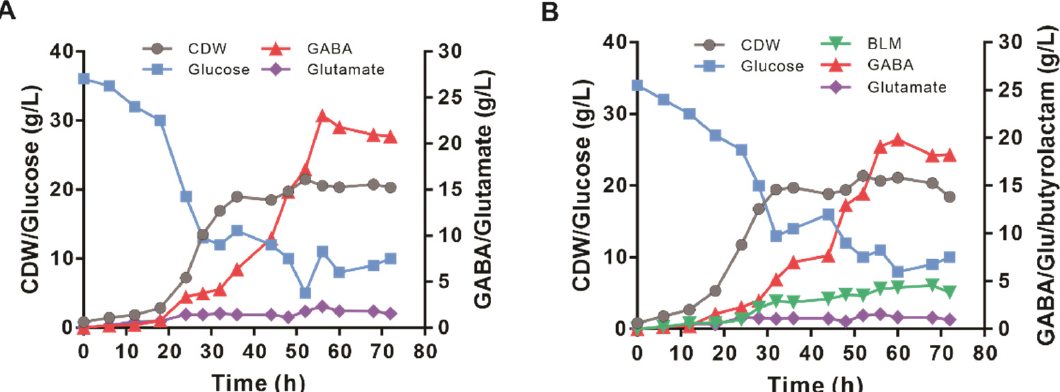
Figure 6. Fed-batch fermentation profiles of the engineered GABA and butyrolactam-producing strains in a 5 L bioreactor. ( A ) Time profiles of cell growth, glucose, glutamate, and GABA concentrations during the fed-batch cultivation of GABA-6 strain are shown. ( B ) Time profiles of cell growth, glucose, glutamate, GABA, and butyrolactam concentrations during the fed-batch cultivation of BLM ‐ 2 strain are shown.